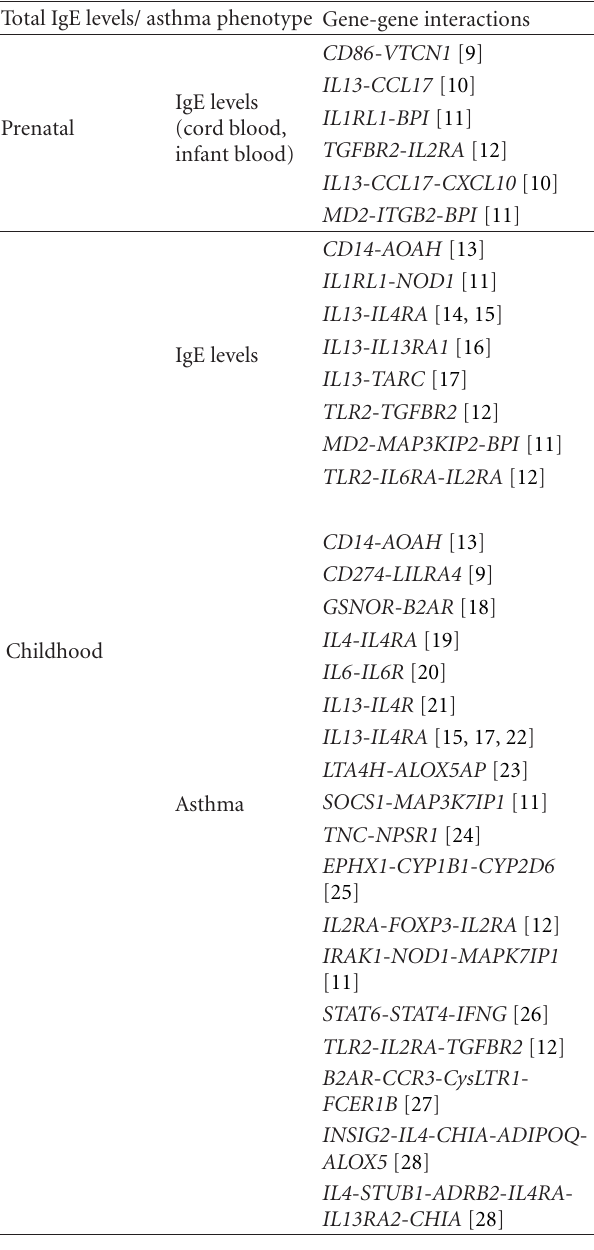
Table 1: Gene-gene interactions on IgE production and asthma